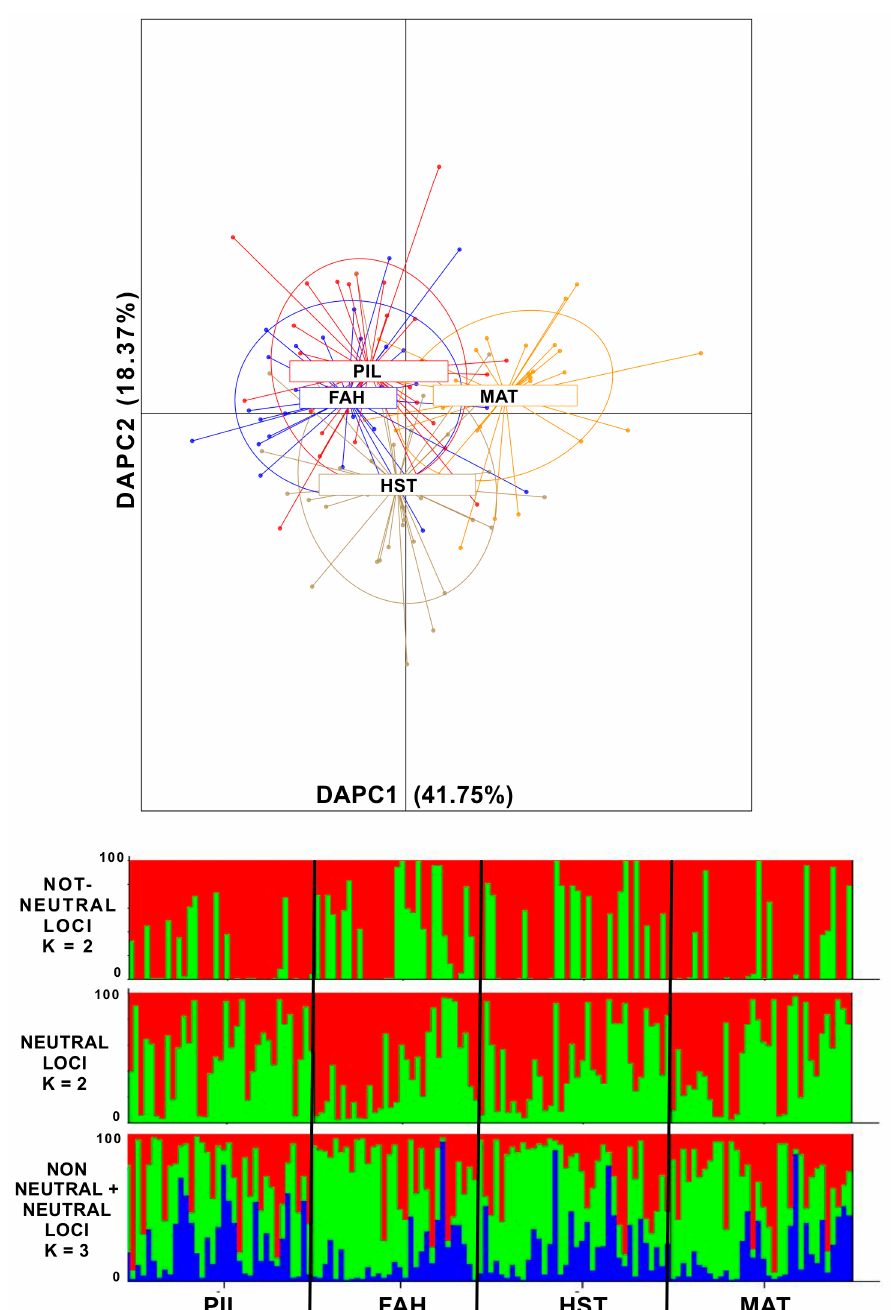
Figure 1. Figure 1 (above) DAPC (Discriminant Analysis of Principal Components) plot of individuals from the four sampling sites along the two most significant axes (PC1 41.75%, PC2 18.37% explained variance). In red are the individuals from Pilgrim Avenue (PIL) and, in blue, are the individuals from Fairhaven (FAH). Both PIL and FAH are located in the inner New Bedford Harbor (NBH) close to the pollution source. Depicted in light brown are individuals from Hacker Street (HST) and, in yellow, are individuals from Mattapoisett (MAT). Both these latter sampling sites are located in the outer NBH area and are exposed to lower pollution concentrations. The insert explains the percent of variance for the first three discrimination eigenvalues (in dark grey are the significant DAs). Figure 1 (below), STRUCTURE plots of the most likely K tested from the simulations with non-neutral (K = 2), only neutral (K = 2), and the complete set of markers analyzed (K = 3).